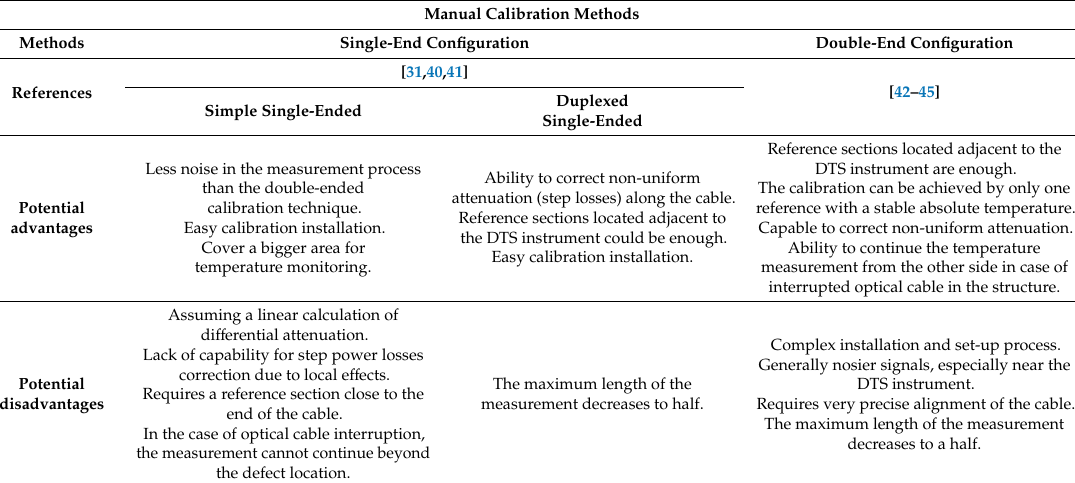
Figure 6. General typology of DTS data calibration. Table 1. Comparative overview of the manual calibration